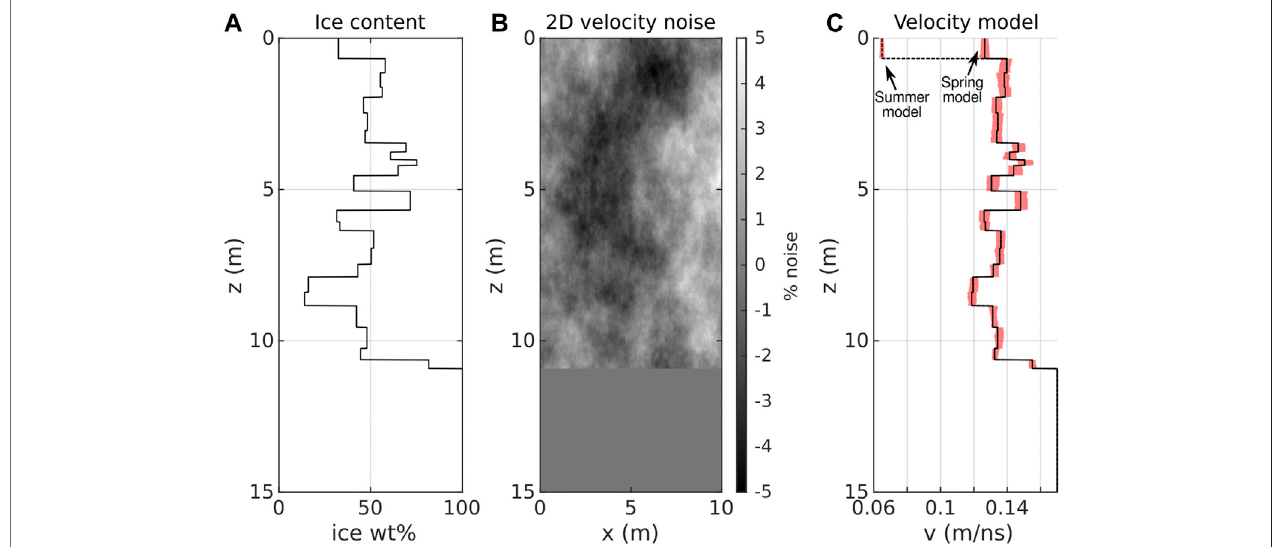
FIGURE10| Constructionofaheterogeneous2DGPRvelocity fi eldforFDTDmodeling. (A) gravimetricicecontentofL14-02(SchwambornandWetterich,2016), (B) 2D stochastic noise fi eld, (C) black: corresponding 1D GPR velocity model (black line) following a 2-phase CRIM model (Birchak et al., 1974) and the velocity range (red area) resulting from superposition with our 2D noise fi eld.